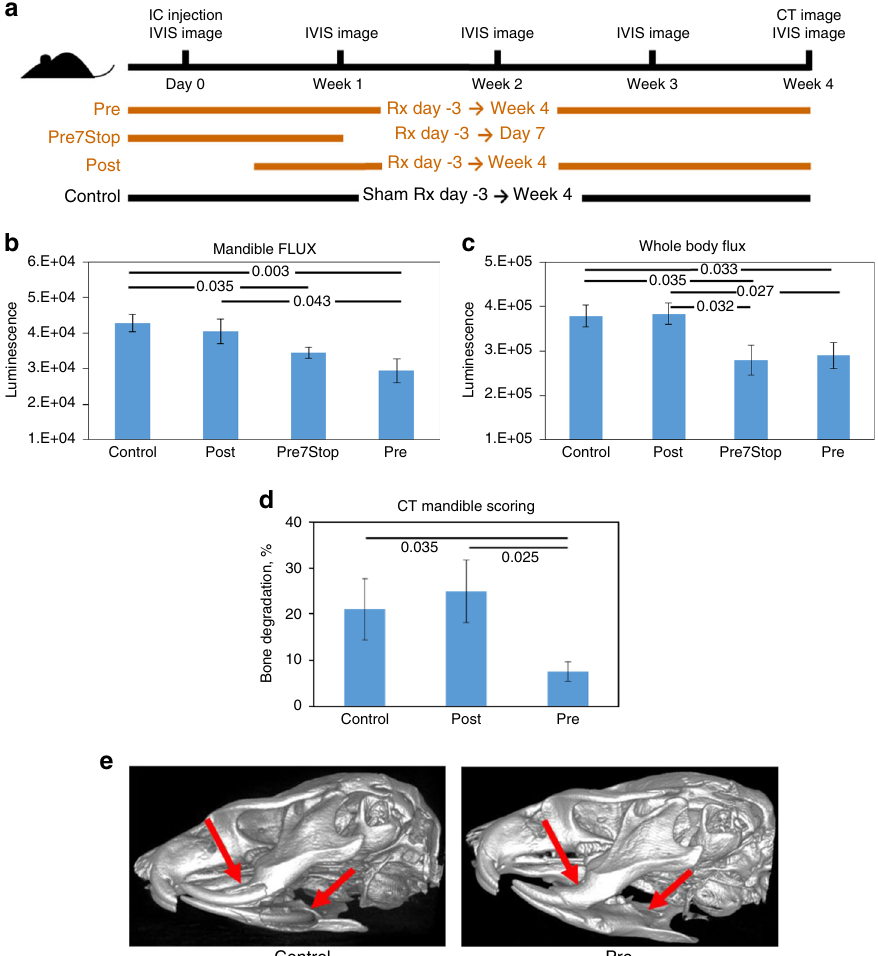
Fig. 3 KBU2046 inhibits bone destruction. a Treatment schema. Athymic mice were given intracardiac (IC) injections of PC3-luc cells on day 0 under ultrasound guidance, and underwent weekly IVIS imaging starting 7 days post injection. Cohorts of N = 20 control, N = 20 pre (treatment from 3 days prior to IC injection through end of the experiment), N = 10 Pre7Stop (treatment from 3 days prior to IC injection through 7 days post IC injection), and N = 10 post-treatment (treatment from 3 days post IC injection through end of the experiment) mice were dosed with 80 mg/kg KBU2046 daily by oral gavage and mock-treated with vehicle all other times. Whole-body ( b ) and mandible ( c ) fl ux are depicted, as determined from weekly IVIS imaging. d At week 4 post injection (i.e., at the end of the experiment), CT scans were performed on control, pre-, and post-treatment cohorts, and mandibular destruction quanti fi ed. e Representative images of pre and control mice are depicted. Arrows denote areas of bone destruction in controls, and corresponding areas in the pre mouse. Student ’ s t -test ( b , c ) and Fisher ’ s exact test ( d ) P values between the denoted cohorts are